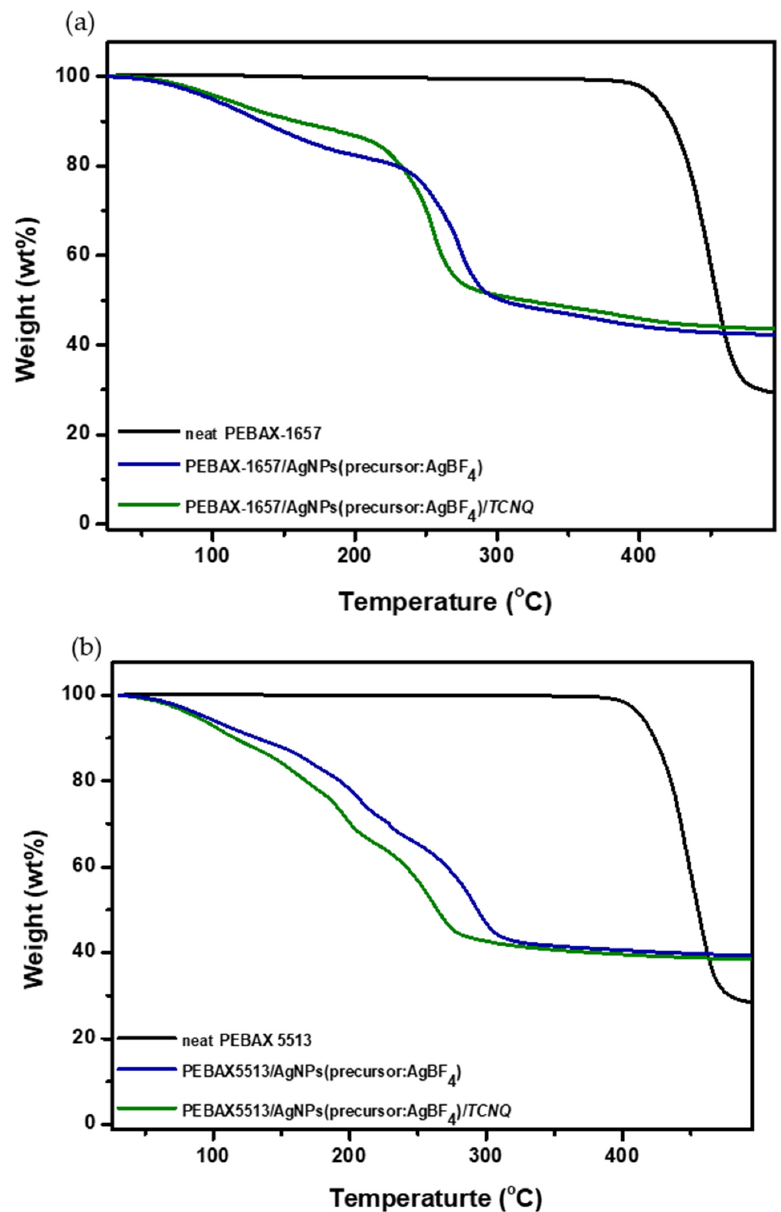
Figure 8. TGA thermograms of ( a ) PEBAX-1657, PEBAX-1657/AgNPs, and PEBAX- 1657/AgNPs/TCNQ, and ( b ) PEBAX-5513, PEBAX-5513/AgNPs, and PEBAX-5513/AgNPs/TCNQ.